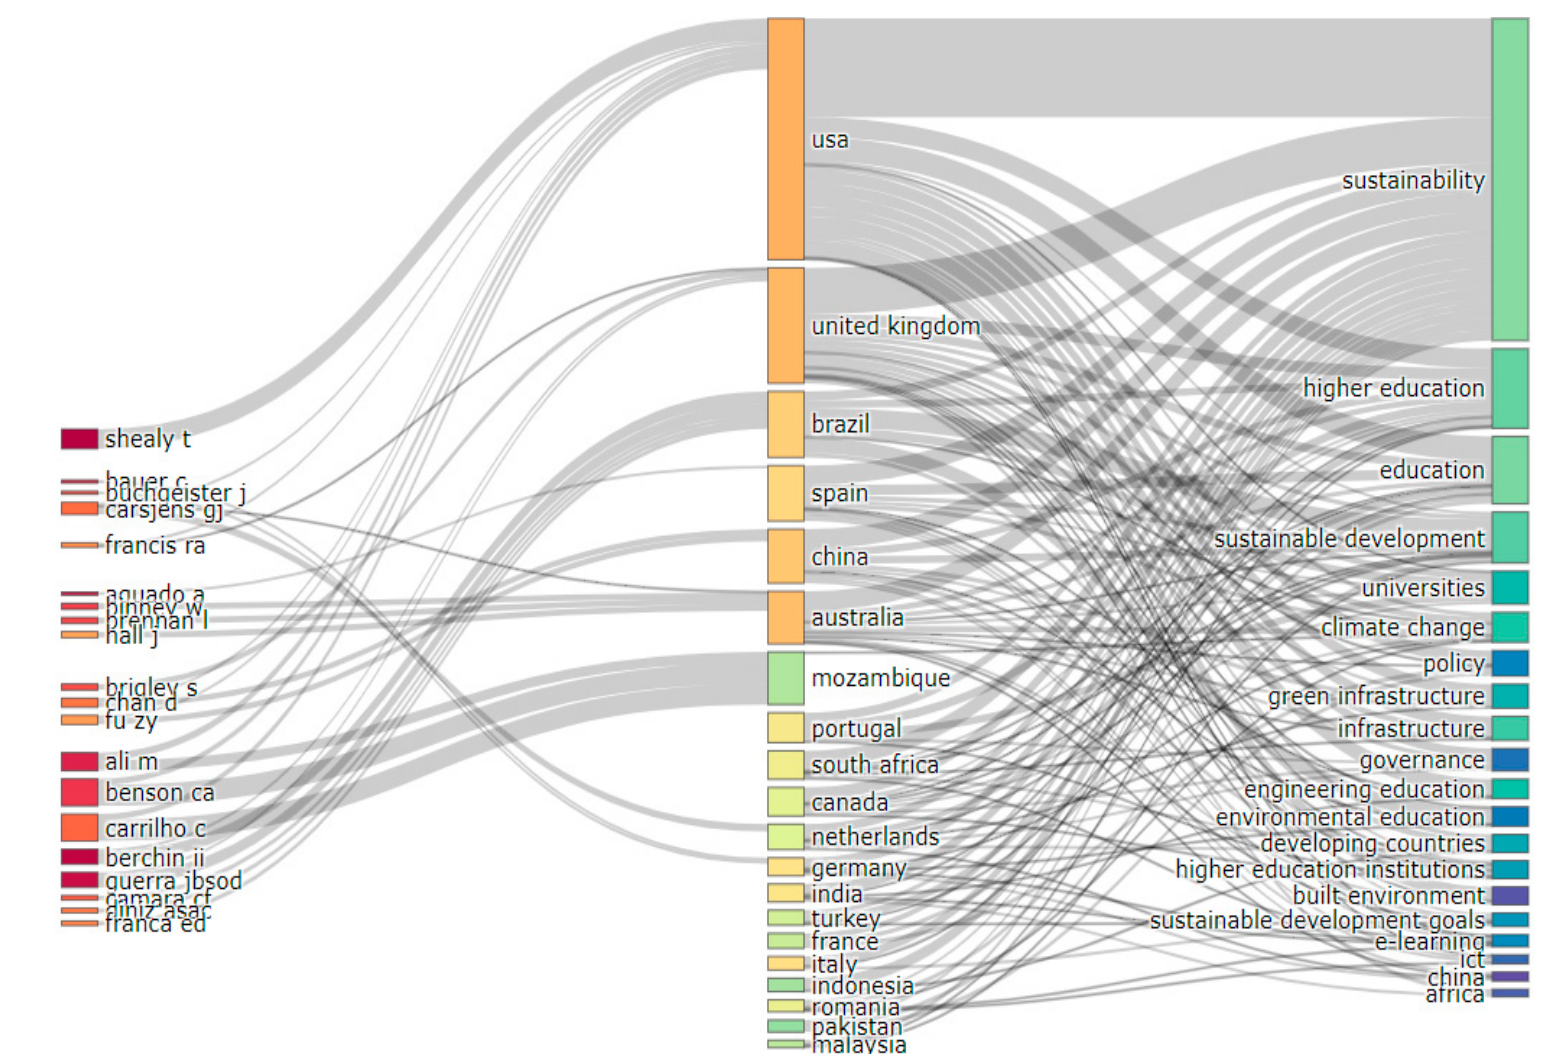
Figure 6. Three plot: authors vs. countries vs. keywords .